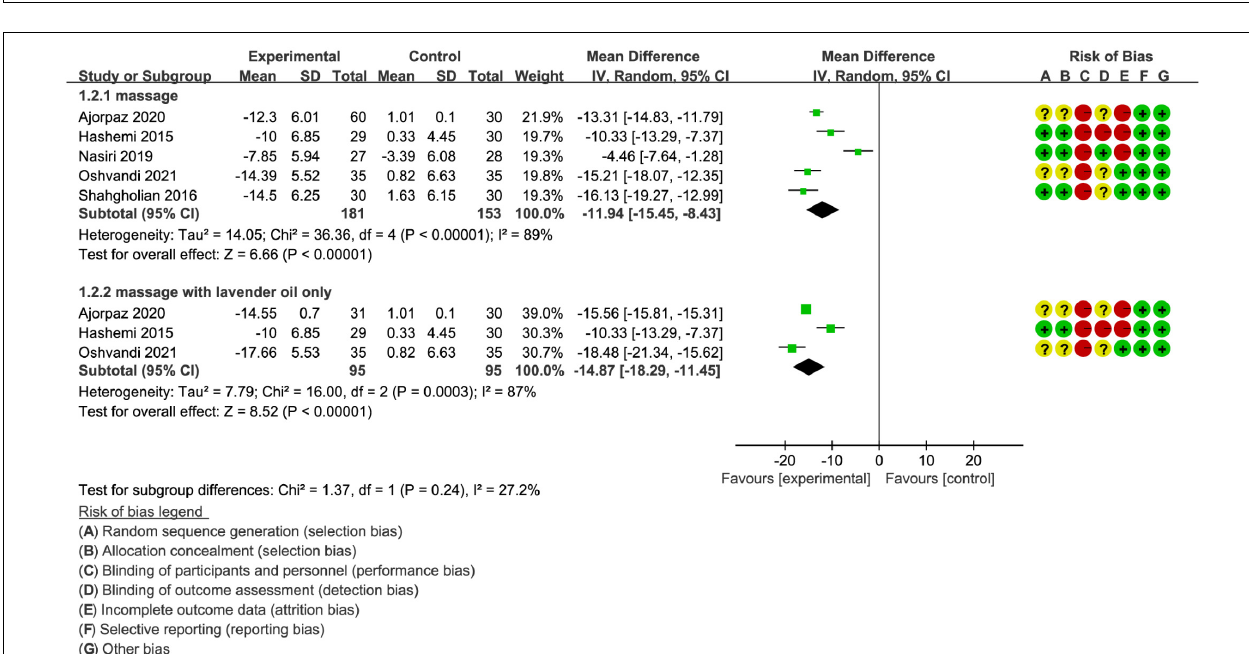
FIGURE 3 | Meta-analysis of International Restless Leg Syndrome Scores (RLSS) after treatment.